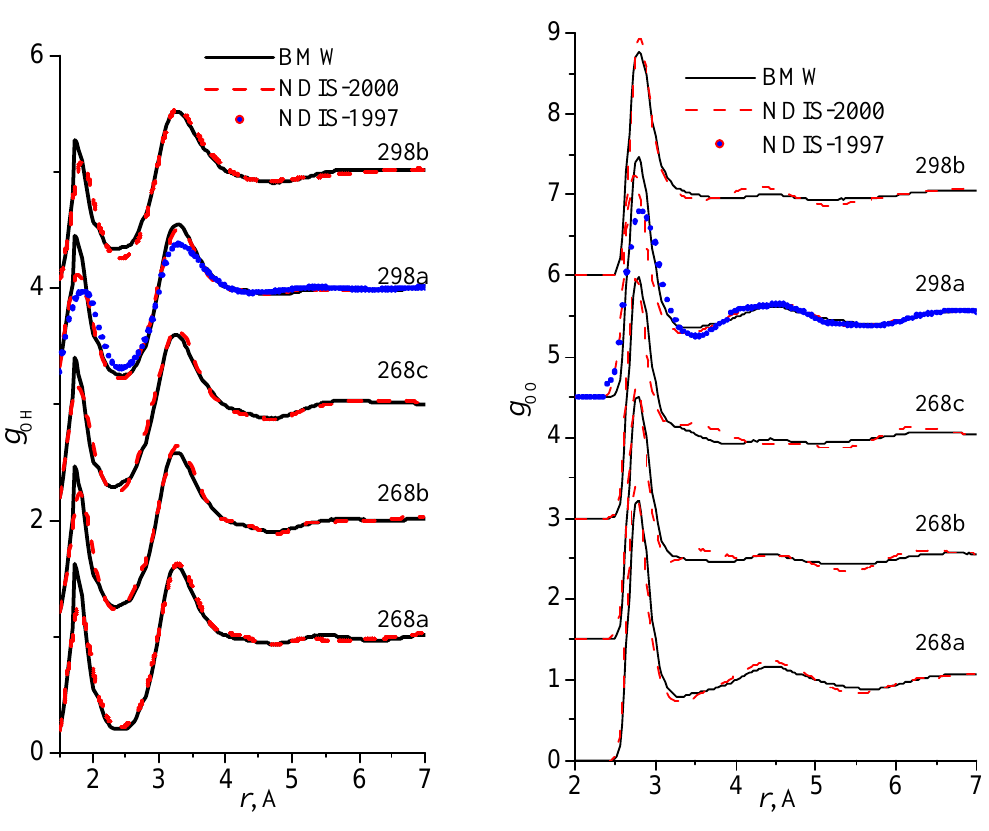
Figure 7. Radial distribution functions g OH